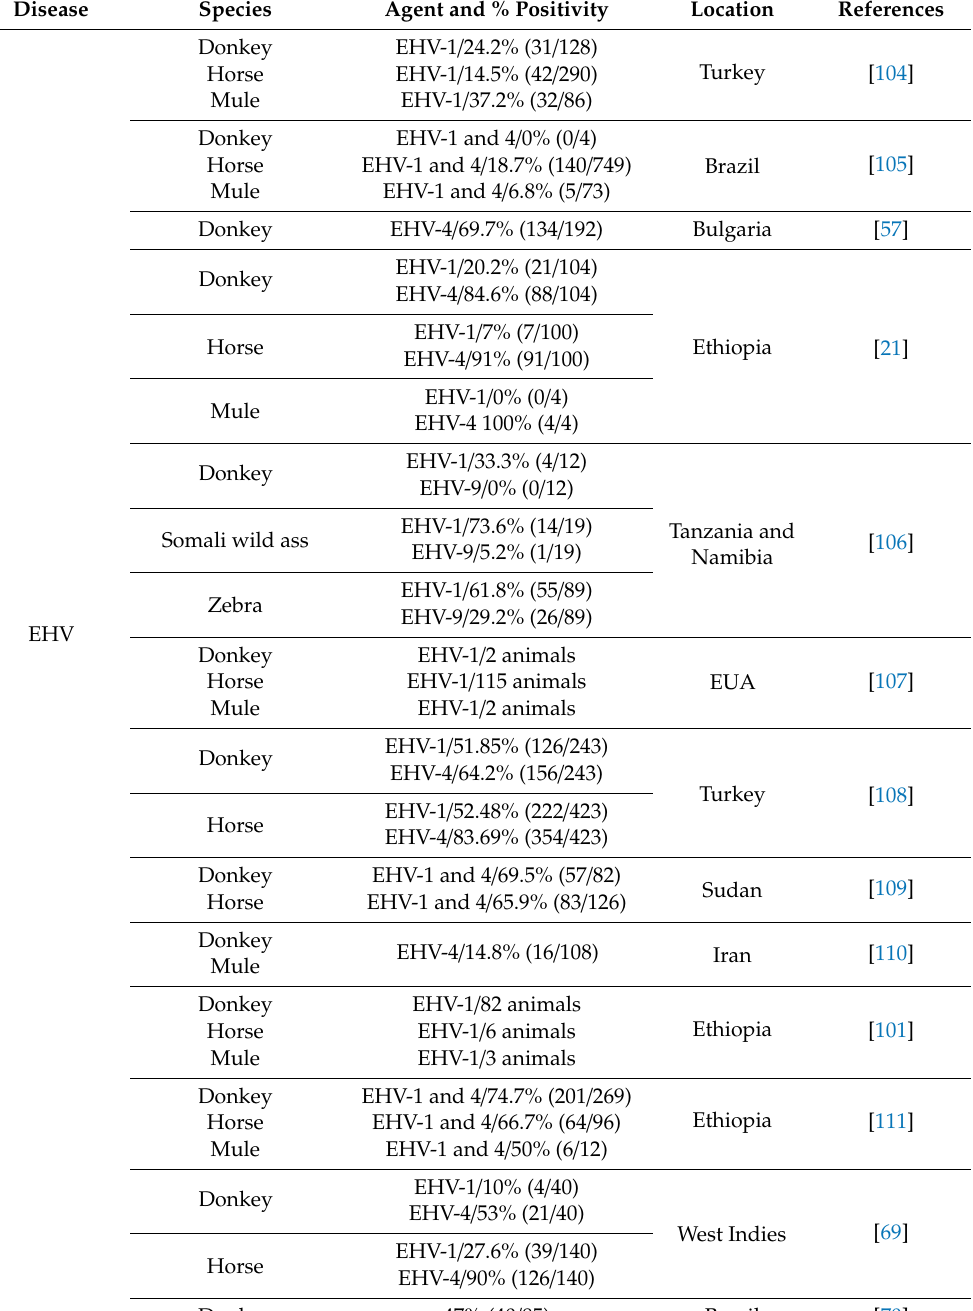
Table 5. Studies on the occurrence of equine herpesvirus, including donkeys and / or mules, from 2009 to